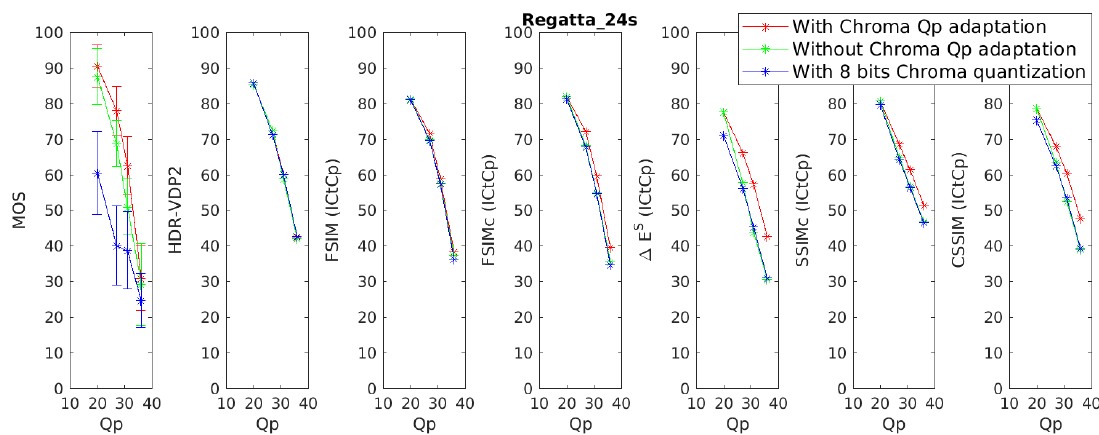
Figure 14. Subjective and objective scores for the image Regatta_24s and for 6 metrics based on the ICtCp color